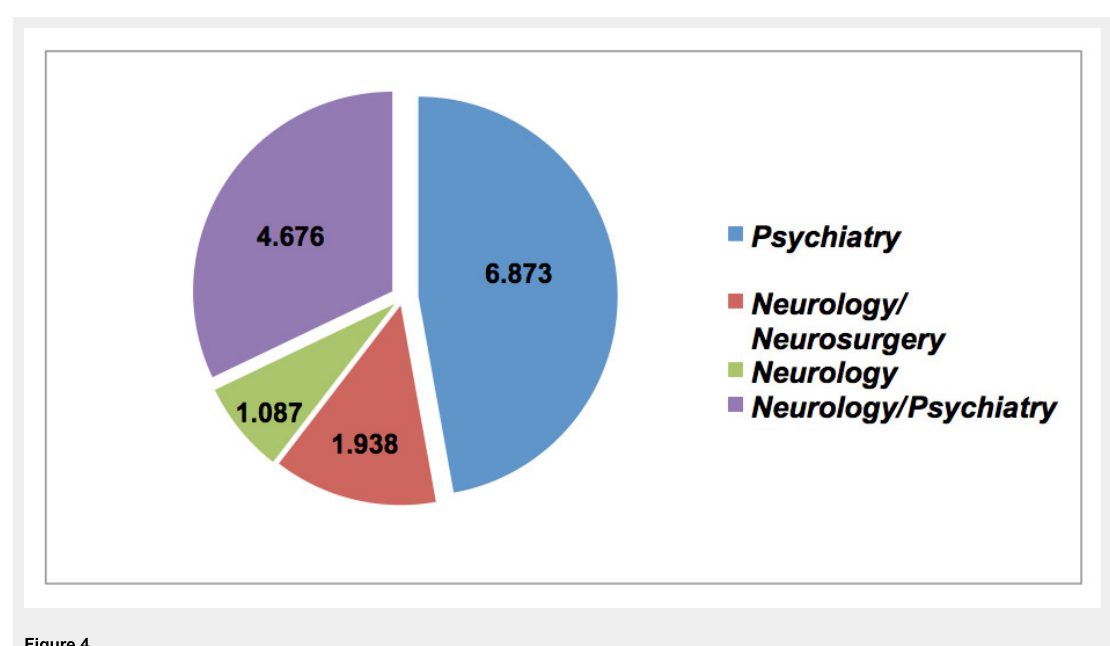
Figure 4 Total costs per discipline (million €PPP,